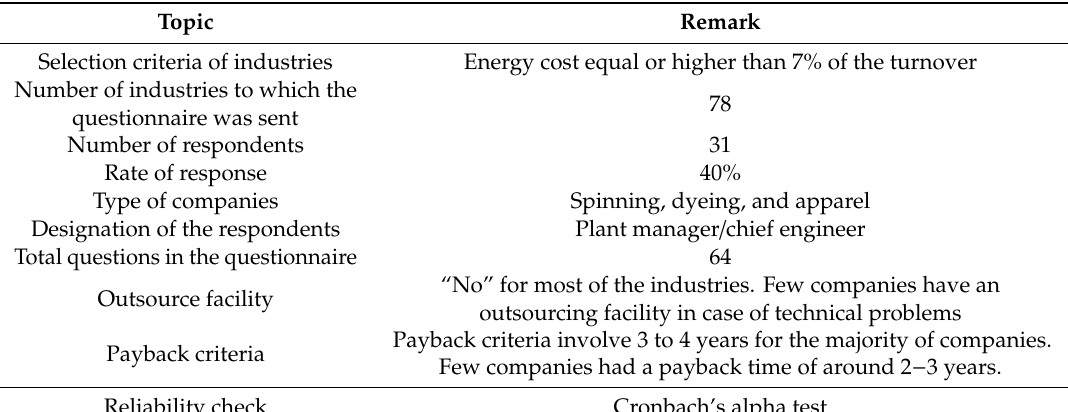
Table 5. Overview of the studied textile